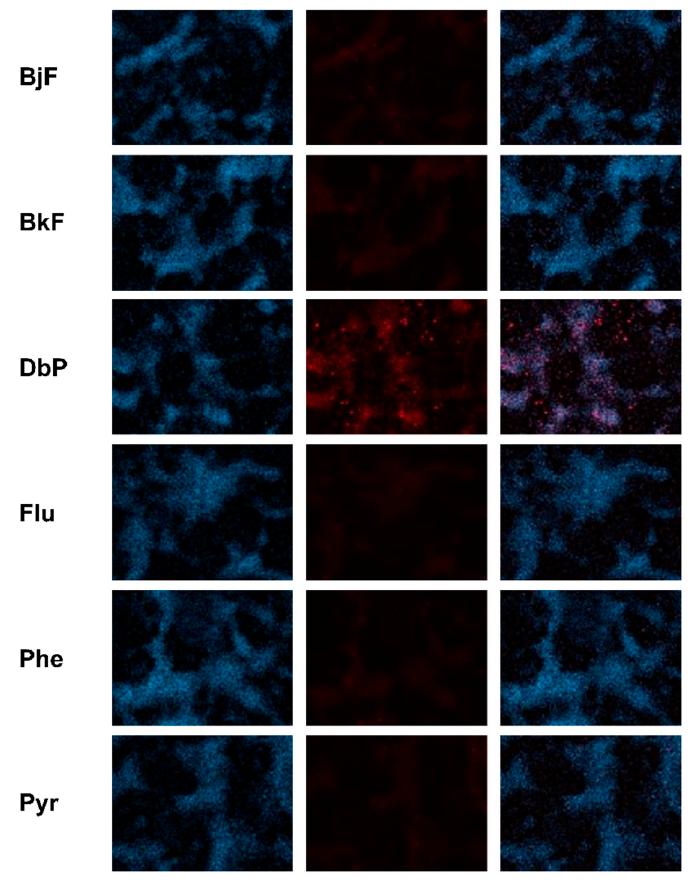
Figure 5. Frequency of histone H2AX phosphorylation. HepaRG cells were treated with 1, 5, or 10 µM of each PAH and incubated for 12, 24, 48 h. Etoposide (Eto; 25 µM) served as a metabolism- independent positive control. Afterward, cells were fixed, blocked, and stained with a combination of primary anti- γ H2AX and secondary Alexa Fluor 647-antibody (red). Nuclei were counterstained using 4 ′ ,6-diamidino-2-phenylindole (DAPI) (blue). The figure depicts representative fluorescence images (brightness +30%) of each channel as well as a merged picture, respectively, 48 h posttreat- ment with solvent control (SC), Eto, or 10 µM PAH. Images were taken with Celldiscoverer (Zeiss, Oberkochen, Germany) and Zeiss Blue software (Zen 3.1 blue edition, Zeiss, Oberkochen, Germany).